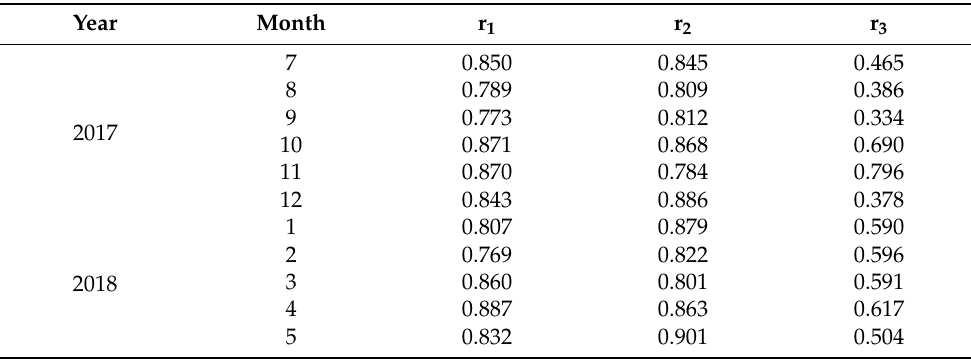
Table 3. Statistics of correlation